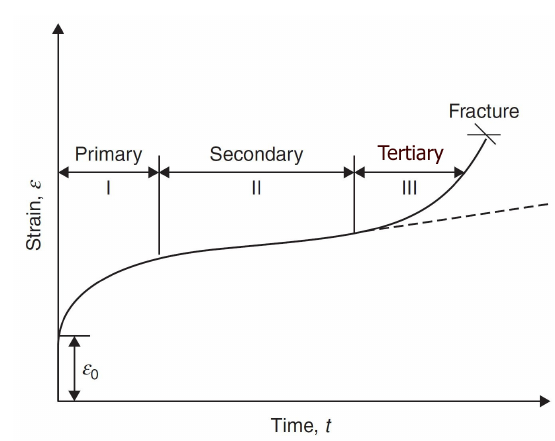
Figure 1. Typical creep curve for materials under load at elevated temperature